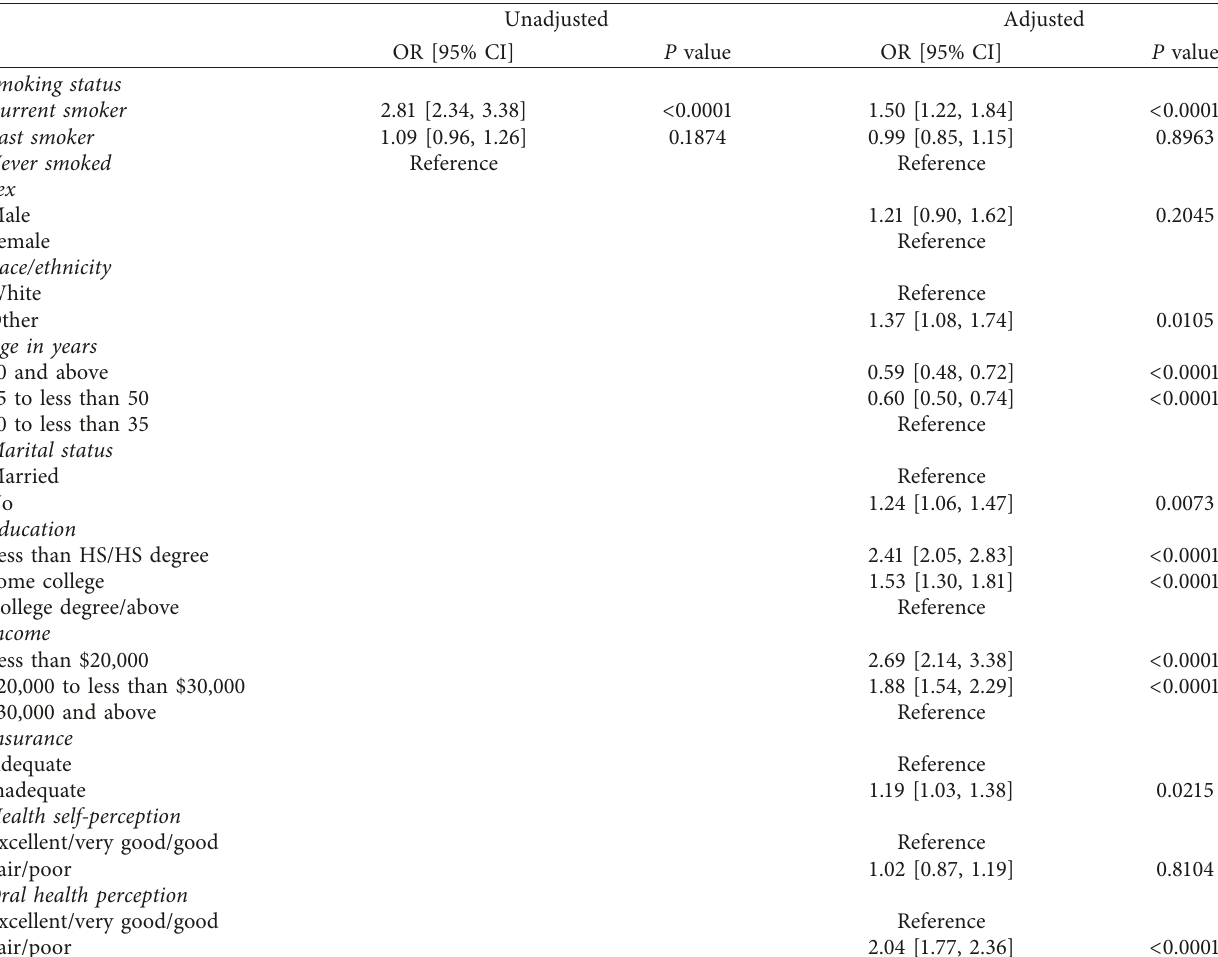
Table 3: Logistic regression of smoking on no reports of dental utilization within the previous 6 months (the National Survey of Veterans,